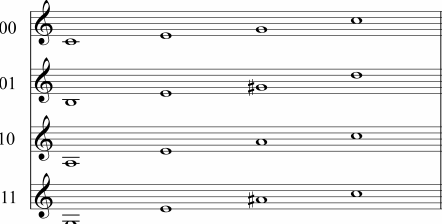
Figure 23. Sources of reference pitches for two-dimensional